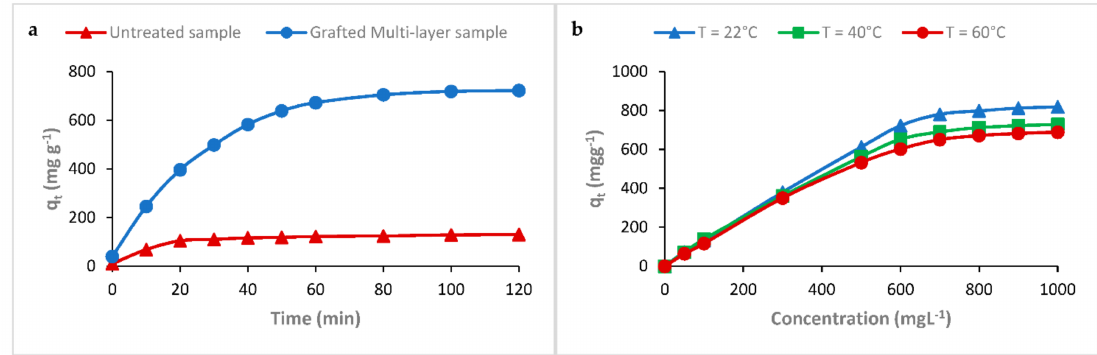
Figure 9. Effect of time contact ( a ) and temperature ( b ) on the adsorption of RR198 onto the PEM bio-sorbent